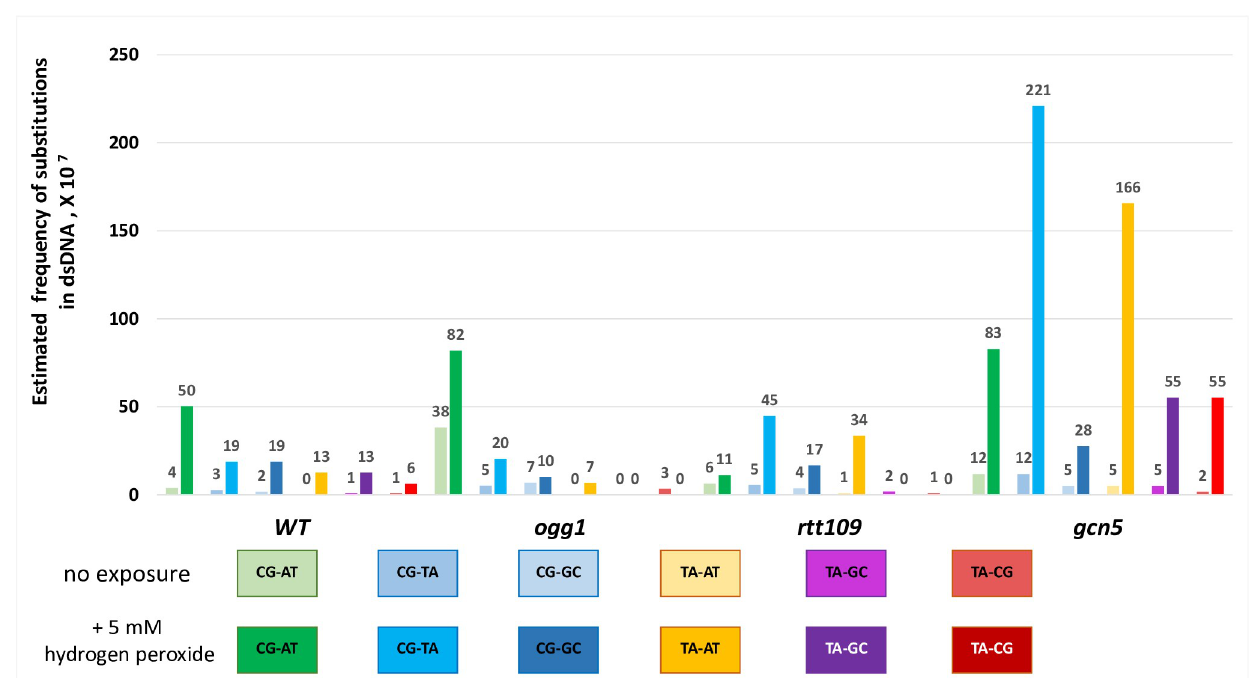
Fig 5. Frequency of mutations at CAN1 locus in dsDNA. Estimated frequency of spontaneous and hydrogen peroxide–induced CanR mutations in dsDNA. Frequencies of all six possible types of substitutions were calculated by multiplication of the total frequency of the mutations for a specific genotype (S2A Fig) by the percent of the corresponding substitution (Fig 6) as identified by Sanger sequencing of the CAN1 locus of CanR isolates at midchromosome triple reporter. Note that these are the frequencies of single mutations at CAN1 locus because in midchromosome reporters, where ssDNA does not form, frequencies of multiple mutations are extremely low. See also S1 Data. CanR, canavanine-resistant; dsDNA, double-stranded DNA.